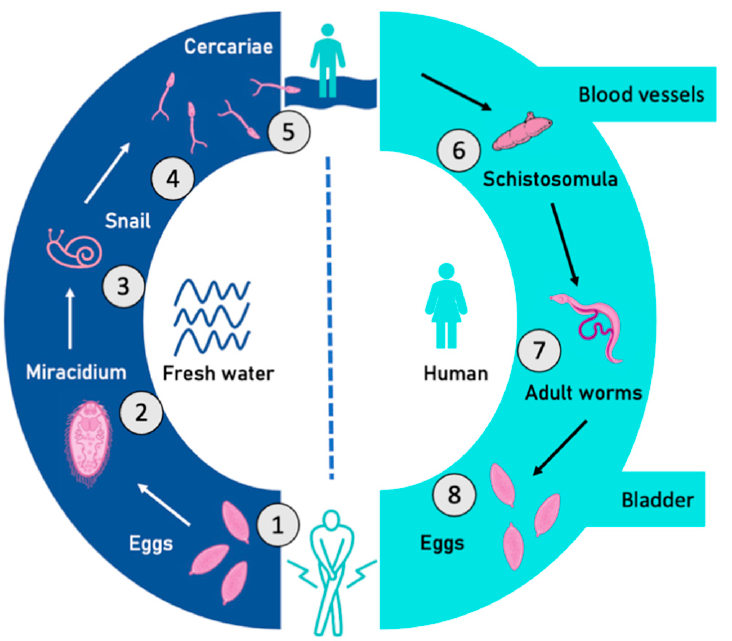
Figure 1. Life cycle of S. haematobium: (1) eggs; (2) miracidium; (3) intermediate snail vector; (4–5) cercariae; (6) schistosomula; (7) male and female worms; and (8) release of eggs deposited in veins of the urinary bladder (original from R. Sánchez-Marqués and M.D. Bargues).